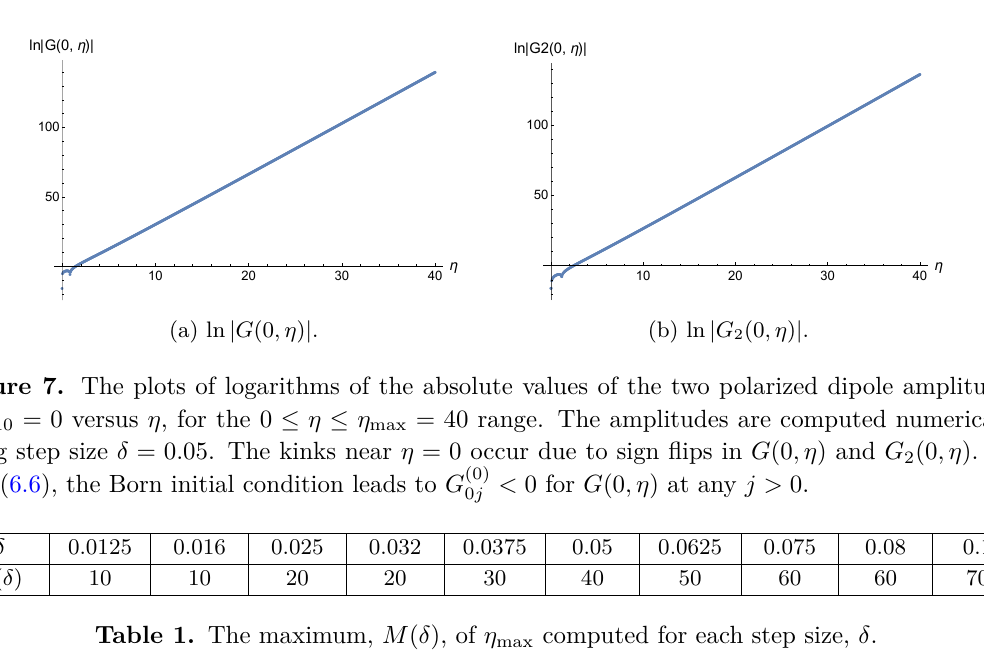
Table 1. The maximum, M ( δ ), of η max computed for each step size, δ